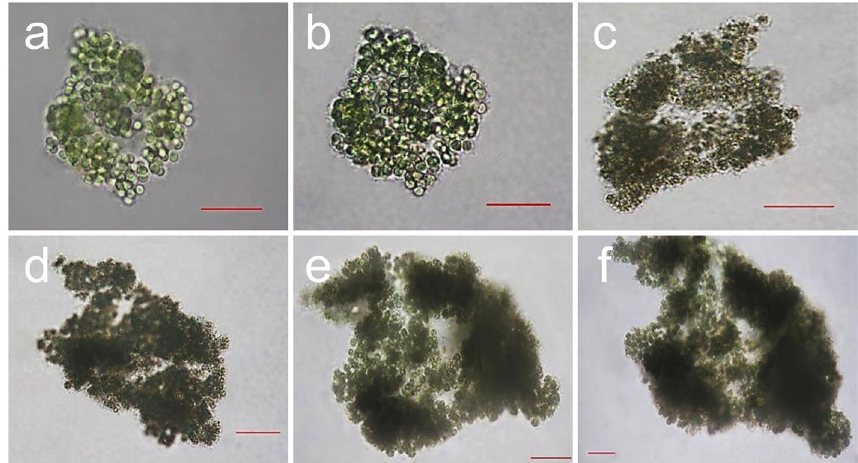
Fig. 6 Microcystis aeruginosa resting‑cell awakening. Scale bar